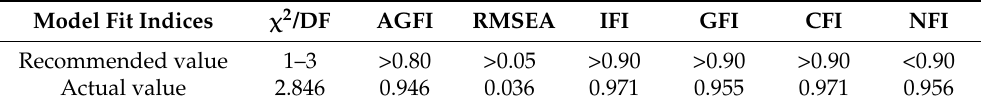
Table 5. Fit indicators of the structural